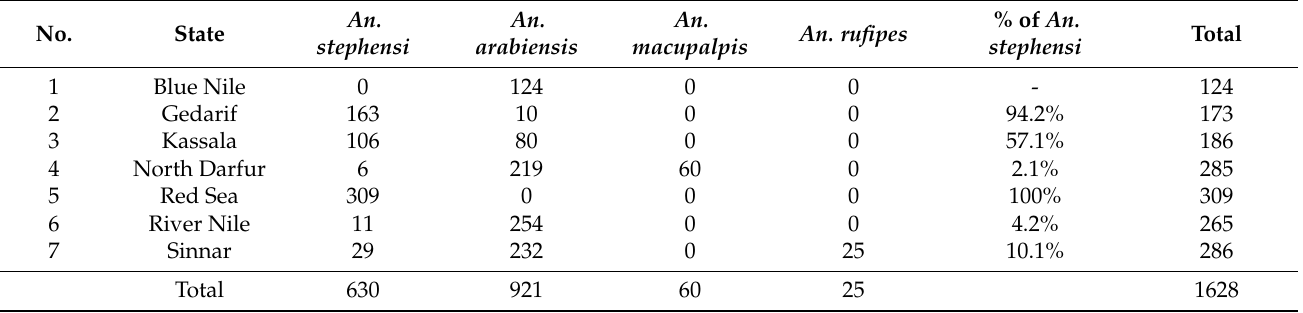
Table 1. Identity and percentage of Anopheles mosquito samples collected by conducting active entomological surveys from different States of Sudan in